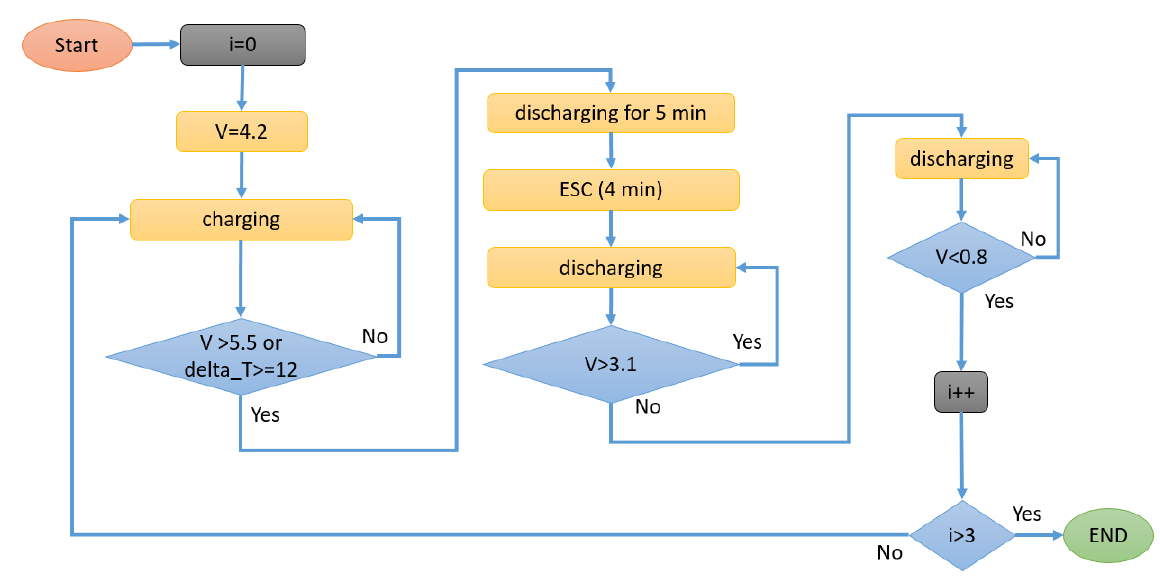
Figure 5. Methodology applied in the mixing